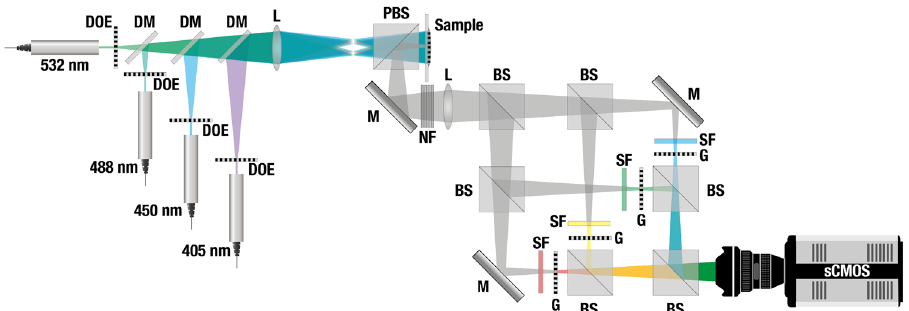
Figure 6. Schematic of the optical setup. The illumination consists of four CW laser sources, each guided through a diffractive optical element (DOE, company Holo/Or) which, when imaged onto the sample, creates a spatial intensity modulation pattern. The fluorescence emitted by the sample is then guided through a detection system where the light is split into four different paths. Each path contains a spectral filter (SF) and a transmission grating (G) which encodes the light. When the modulated fluorescence signal is transmitted through the gratings a unique beating pattern is created. This grants optical tracing abilities from the light source to the detector. DM = Dichroic Mirror, L = Lens, PBS = Polarizing Beam Splitter, M = Mirror, BS = Beam Splitter. NF = Notch